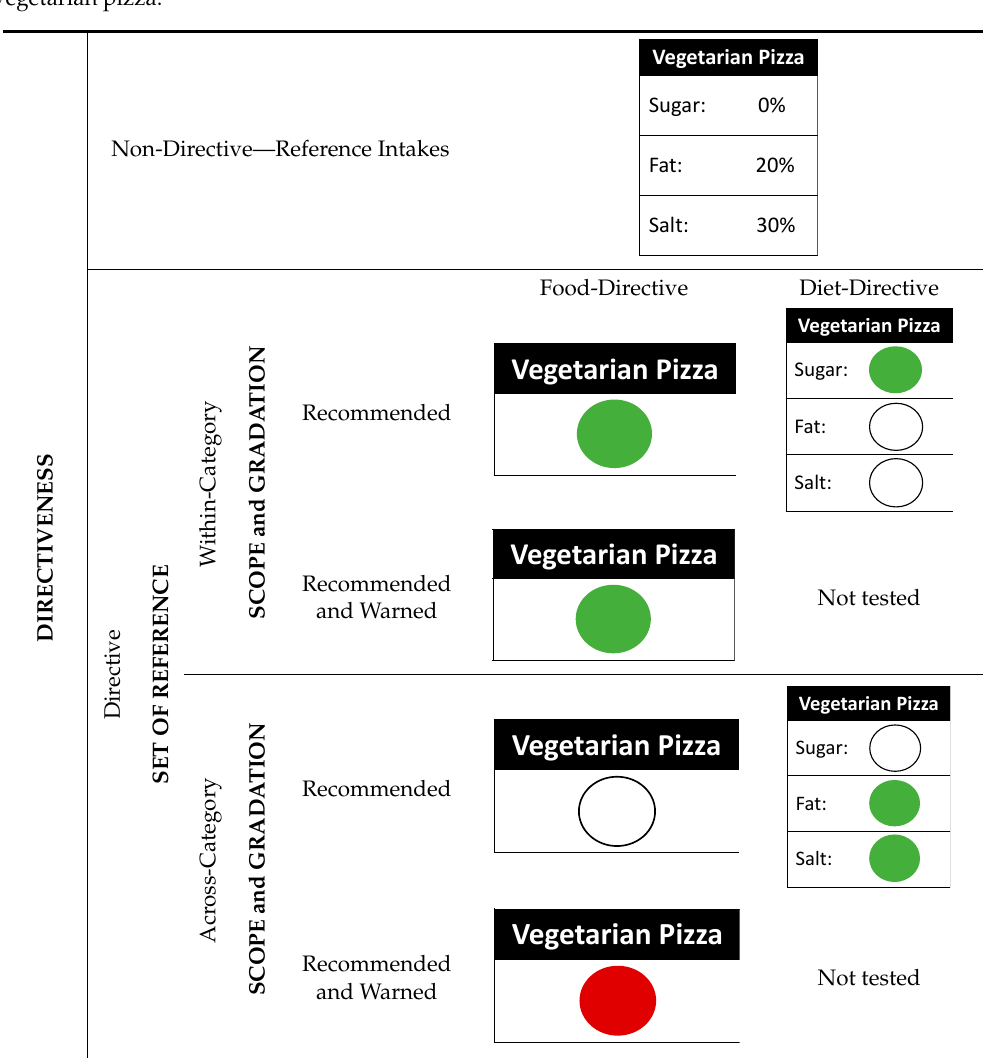
Figure A13. NutrInform Battery (Italy) is based on the Reference Intake Label (Figure A3) with an added battery symbol indicating the amounts of energy and nutrients in a single serving as a percentage of the daily intake. Directiveness: Non-Directive; Scope: All food; Gradation: Cardinal; Set